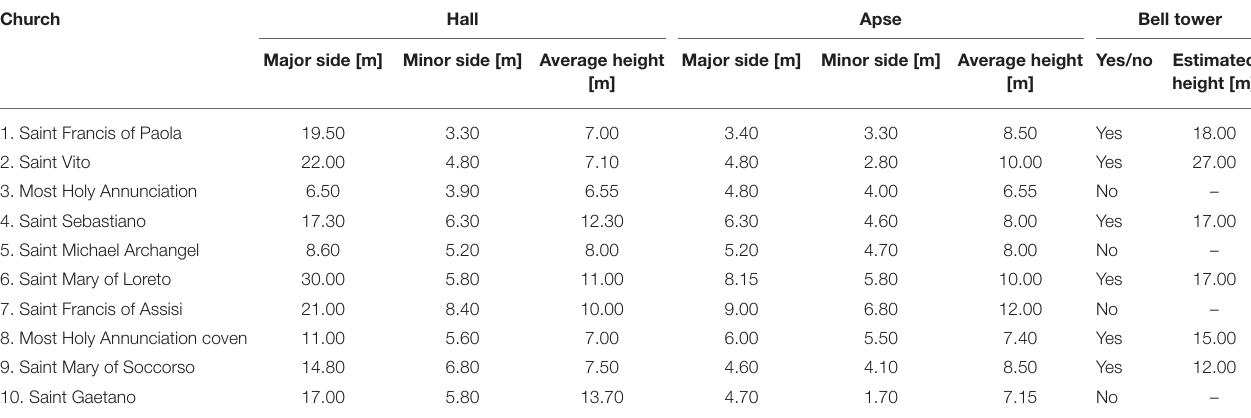
TABLE 6 | Geometrical features of churches investigated in Ischia.